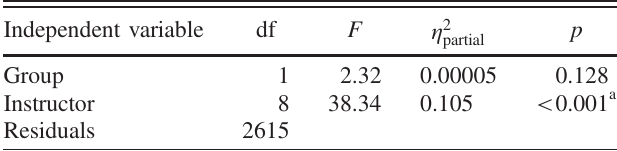
TABLE II. The ANOVA analysis of students ’ difference scores on the final exams at each institution shows no significant effect for enrolling in the lab.